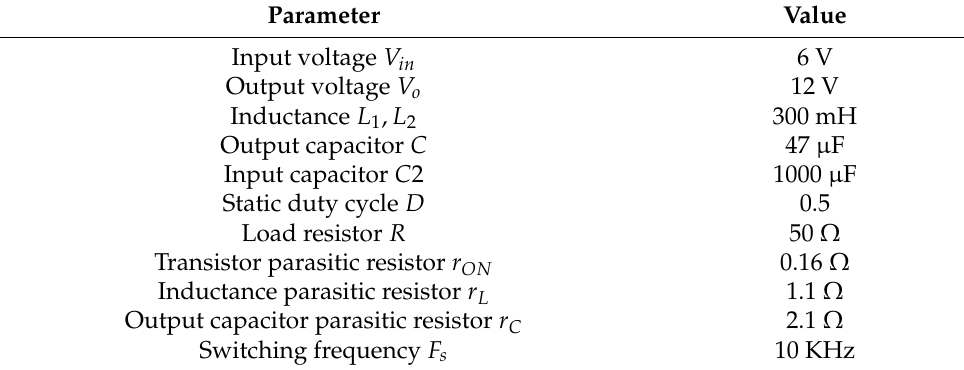
Table 3. The 2IBC technical